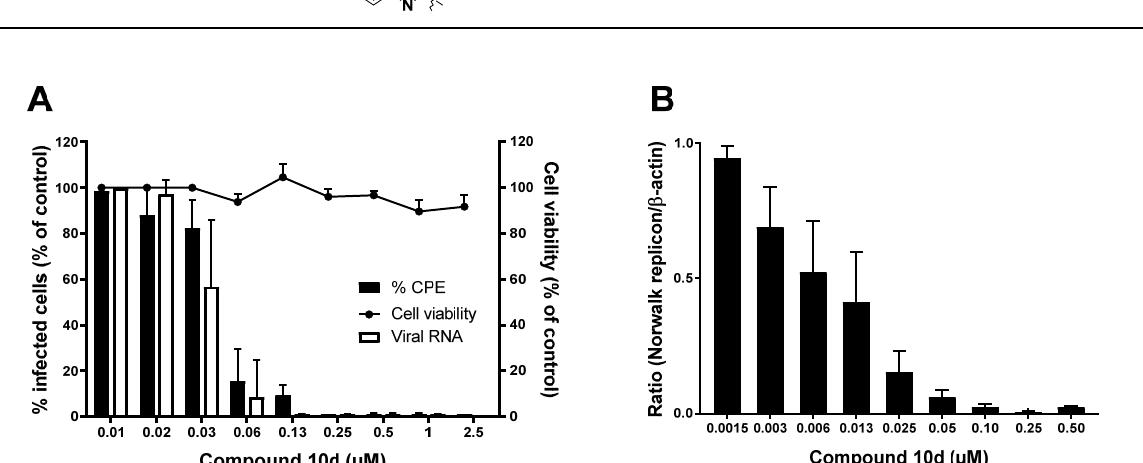
Figure 5. The antiviral effect of compound 10d against MNV and the HuNoV GI.1 replicon. ( A ) The antiviral activity of compound 10d against MNV was quantified by (i) virus-induced CPE reduction and (ii) reduction in viral RNA levels. Cellular toxicity was assessed in parallel. n = 3–4 ( ± SEM). ( B ) The antiviral activity of compound 10d against the HuNoV GI.1 replicon. Intracellular RNA loads are represented by relative genome quantification of the HuNoV GI.1 replicon versus β -actin. n = 3 (±SEM).